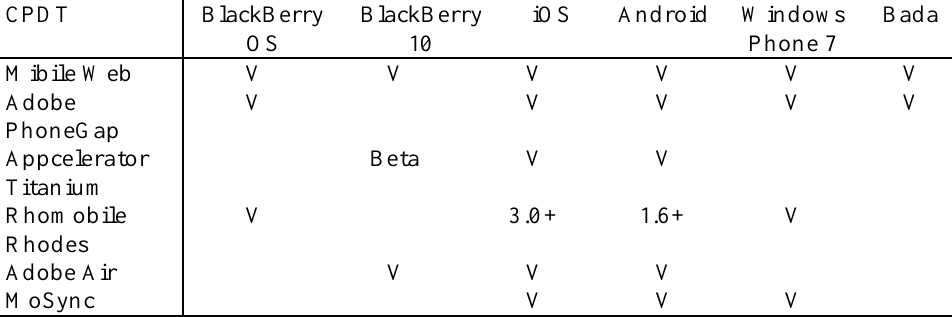
Tools for Cross-Platfrom Application Development (Dhillon,